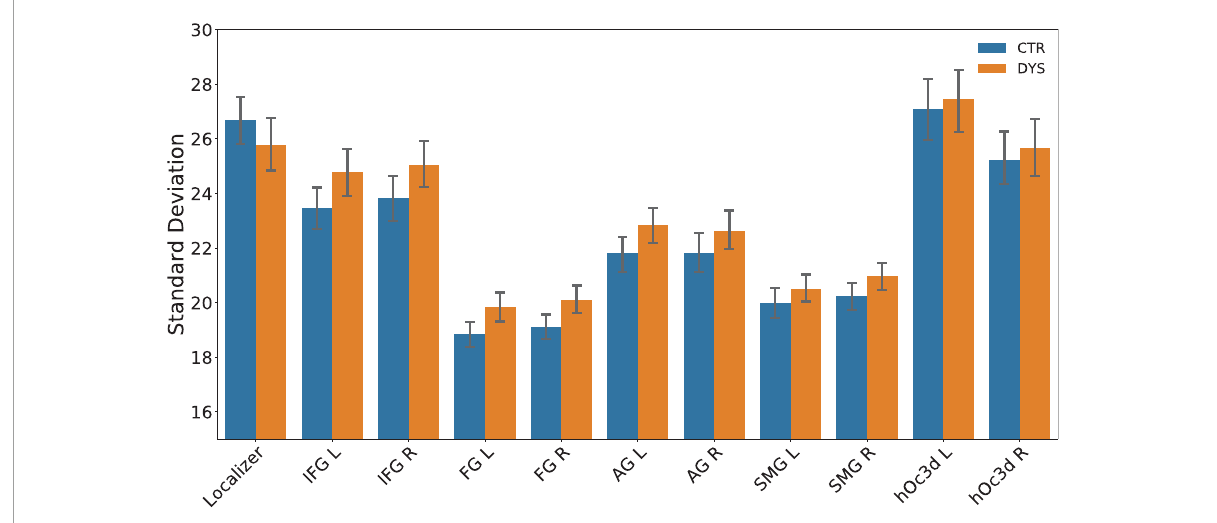
FIGURE8 The mean intra-word variability (mean SD) across the 12 repetitions of beta values in each ROI for the control (CTR) and dyslexic (DYS) group. IFG: inferior frontal gyrus, FG: fusiform gyrus, AG: angular gyrus, SMG: supramarginal gyrus, hOc3d: dorsal extrastriate cortex, L: left hemisphere, R: right